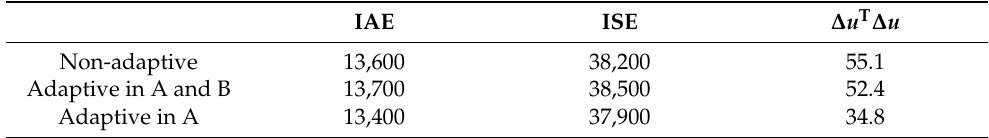
Table 4. The controller performance for a 20% increase in the glucose feed concentration between 100 and 150 h.